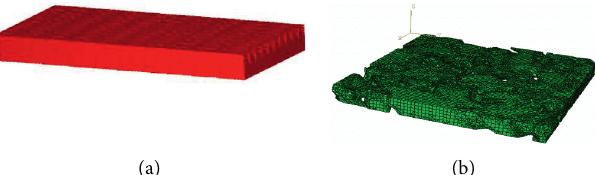
Figure 3: Reconstruction of AC pavement model with different methods. (a) QSGS method combined with BA networks. (b) CTscanning technology. Table 1: Permeability coefficient of asphalt pavement models. Models